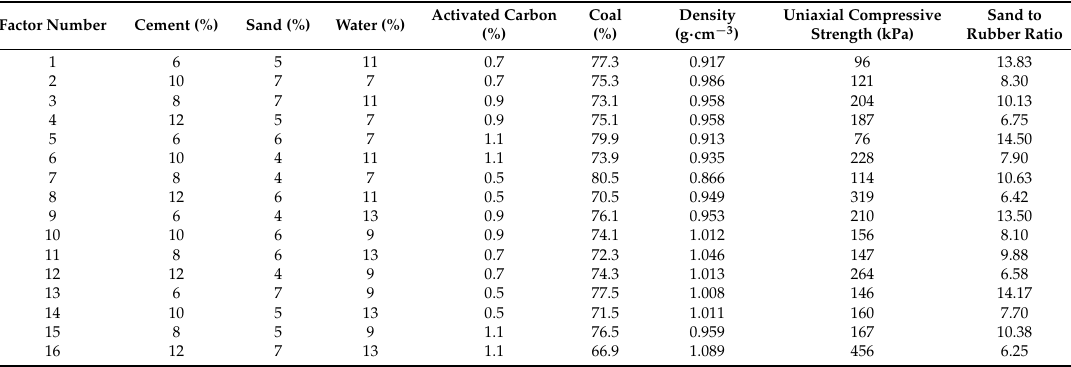
Table 2. Low-strength orthogonal ratio test scheme for coal seam similar